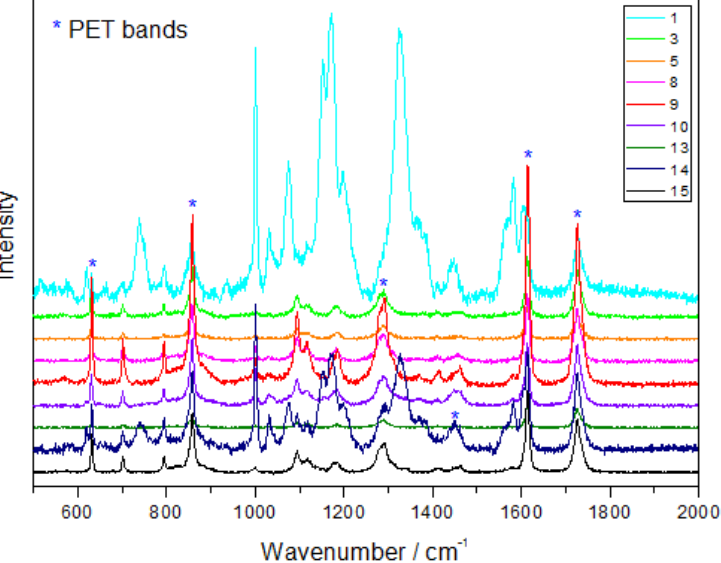
Figure 6. The Raman spectrum of PET, acquired using the Raman spectroscopy. The samples from the Barents Sea are numbered from 1 to 8, and those from the tundra lakes are numbered from 9 to 15. On average, 67% of the fibers found in the bays and 60% of those found in the lakes made from this polymer. The PET fibers were the most abundant (100%) in Lake 1, which is closest to the field station, and Barents Sea, but the results were not statistically significant (Figure 4A). The remaining fibers (on average, 33% of fibers in the bays and 40% in the lakes) were identified as rayon, which are semi-synthetic cellulose-based fibers (Figure 7).